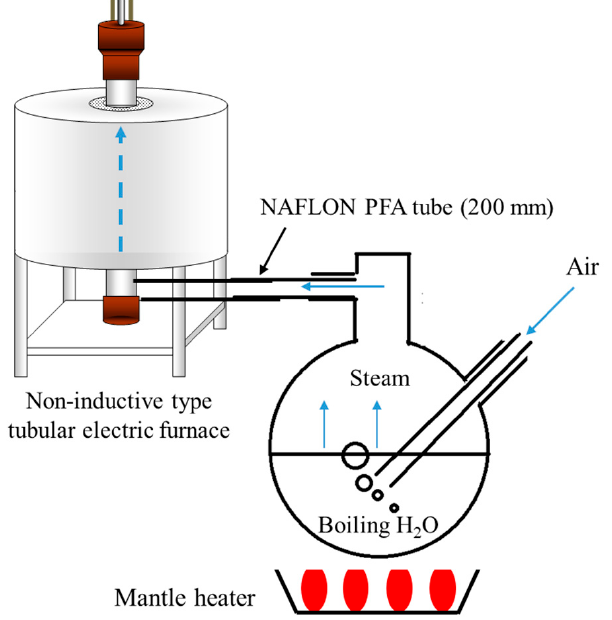
Figure 2. Apparatus for conductivity measurements under steam stream.